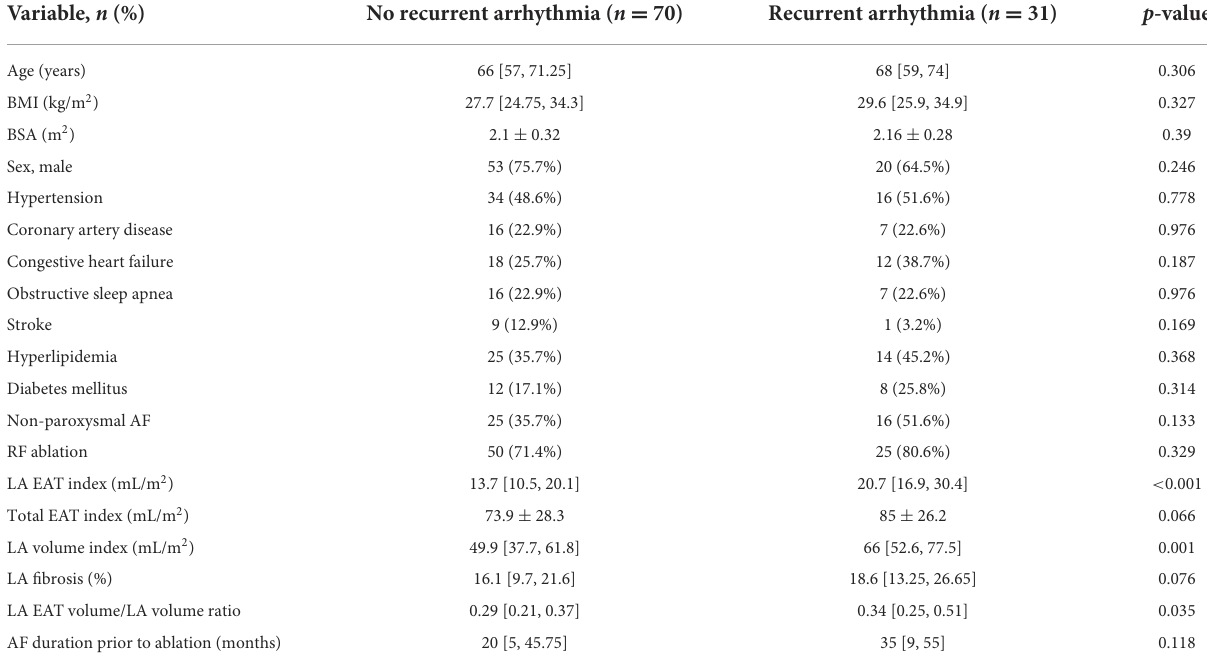
TABLE 1 Baseline characteristics of patients with and without post ablation arrhythmia recurrence. Variable, n (%) No recurrent arrhythmia ( n =